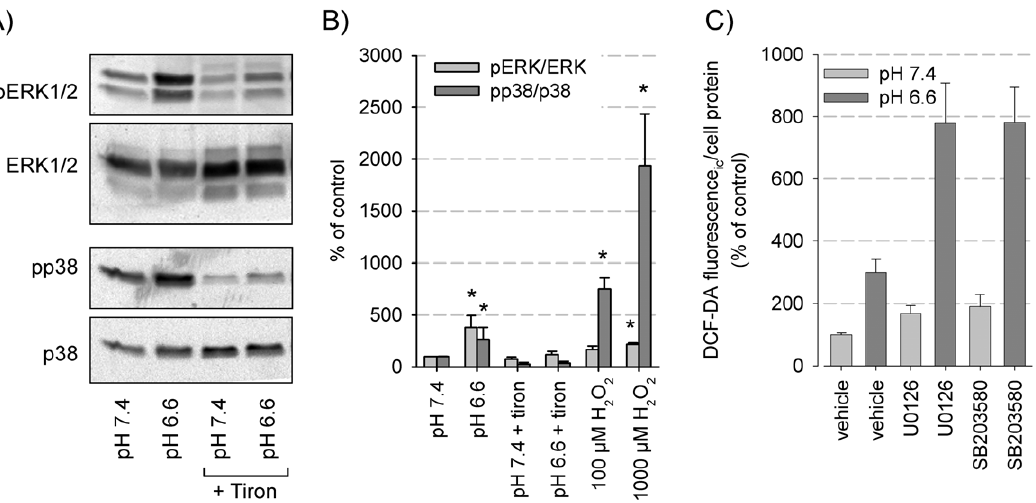
Figure 7. Impact of acidosis-induced ROS formation on MAPK activation. (A) Typical western blot for phosphorylated and overall protein of ERK1/2 and p38 in AT1 after an incubation period of 3 h in either pH 7.4 or pH 6.6 in the absence or presence of the ROS scavenger tiron. (B) Impact of ROS scavenging under acidic conditions or H 2 O 2 incubation (at pH 7.4) on ERK1/2 and p38 phosphorylation. Values are normalized to control conditions at pH 7.4 (N=6–7). (C) Effect of ERK1/2 (U0126) or p38 (SB203580) inhibition on ROS formation (N=9–12). (*) p , 0.05.